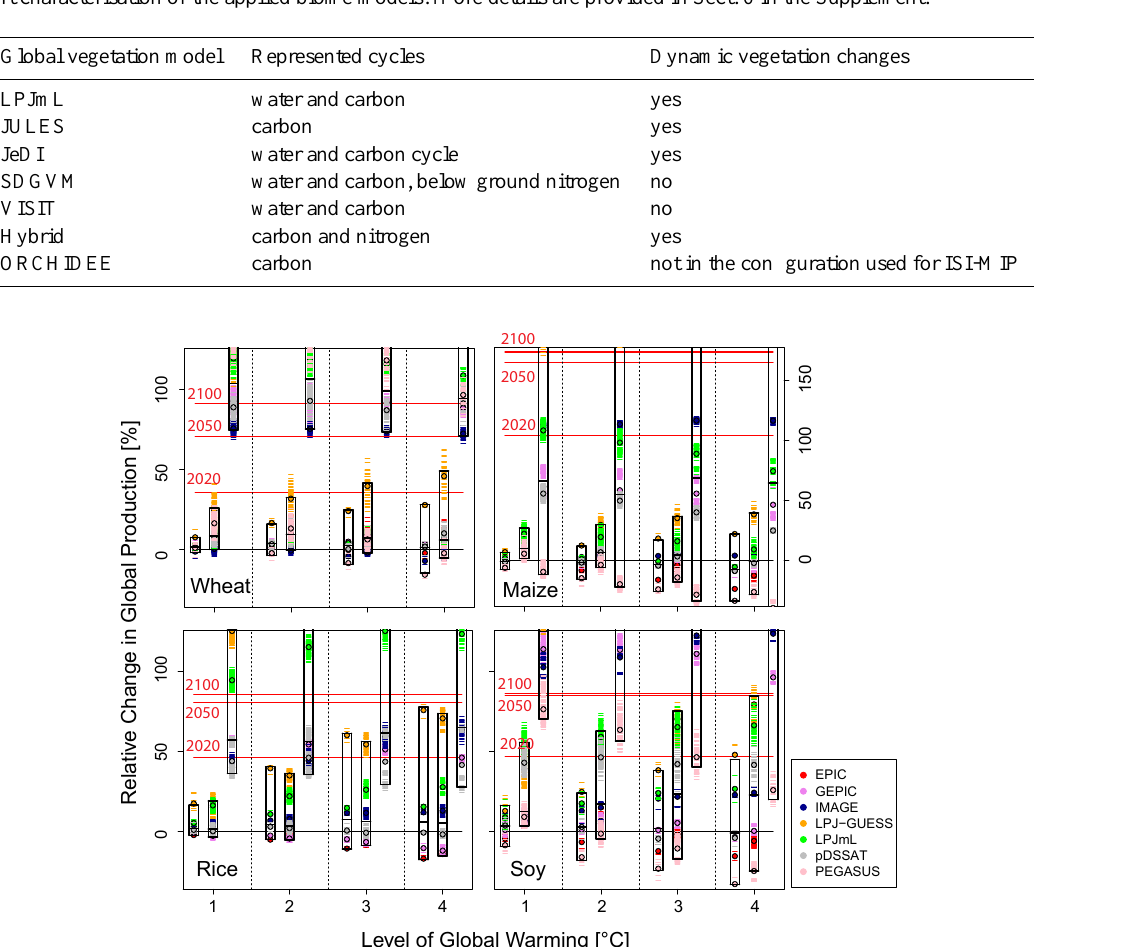
Figure 3. Adaptive pressure on global crop production and effects of irrigation and LU adaptation. Relative changes in crop global production (wheat, maize, rice, soy) at different levels of global warming with respect to the reference data (global production under unlimited irrigation on currently irrigated land, averaged over the 1980–2010 reference period). Horizontal red lines indicate the relative change in demand projections for the years 2020, 2050, and 2100 due to changes in population and GDP under SSP2. First column of each global mean warming block: change in global production under fixed current LU patterns assuming unlimited irrigation restricted to present-day irrigated land. Second block: relative change (with regard to reference data) in global production assuming potential expansion of irrigated land accounting for irrigation water constraints as projected by 11 water models (for details see the Supplement). Third column: based on the same water distribution scheme as column 2 but applied to the 2085 LU pattern provided by MAgPIE. EPIC is excluded from the LU experiment as simulations are restricted to present-day agricultural land. Colour coding indicates the GGCM. Horizontal bars represent results for individual climate models, RCPs, GGCMs, and hydrological models (for column 2 and 3). Coloured dots represent the GGCM- specific means over all GCMs and RCPs (and hydrological models). Black boxes mark the inner 90% range of all individual model runs. The central black bar of each box represents the median over all individual